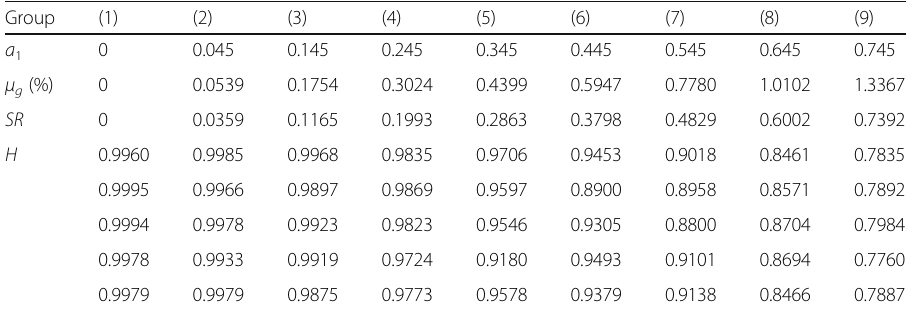
Table 4 Results on conditional entropy. The table reports the Sharpe ratio and conditional entropy for nine AR (1) processes with different parameters. The Sharpe ratio is denoted by SR , and the conditional entropy is denoted by H